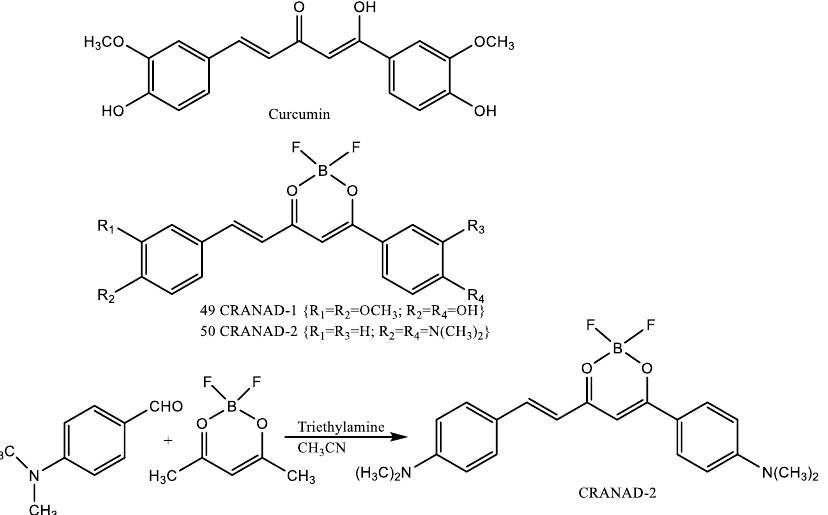
Scheme 10. ( Top ) Structure of curcumin, compound 49 (CRANAD-1), and compound 50 (CRANAD-2); ( bottom ) synthetic route for CRANAD-2.